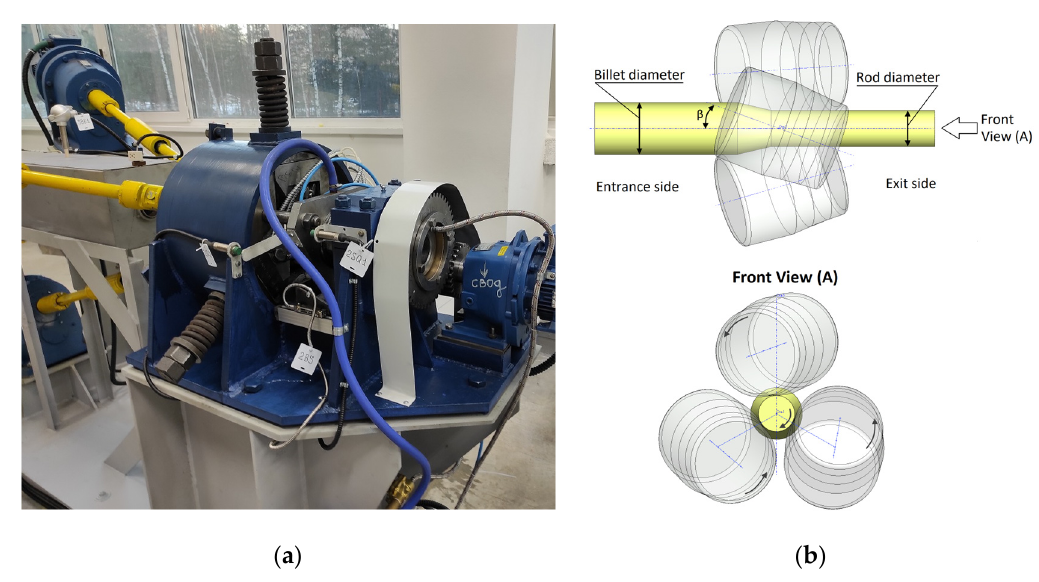
Figure 1. RSR Minimill “MISIS 14–40” ( a ) and schematic diagram of RSR ( b ). Table 2. Modes of radial shear rolling. The total elongation ratio Σ µ (that is, the ratio of the cross-sectional area of the